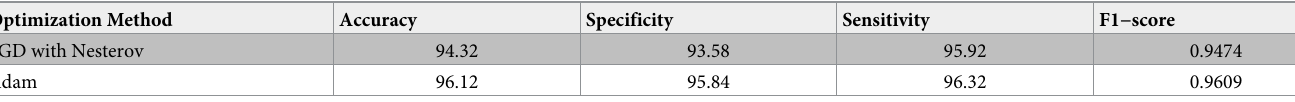
Table 7. Results of optimization methods.